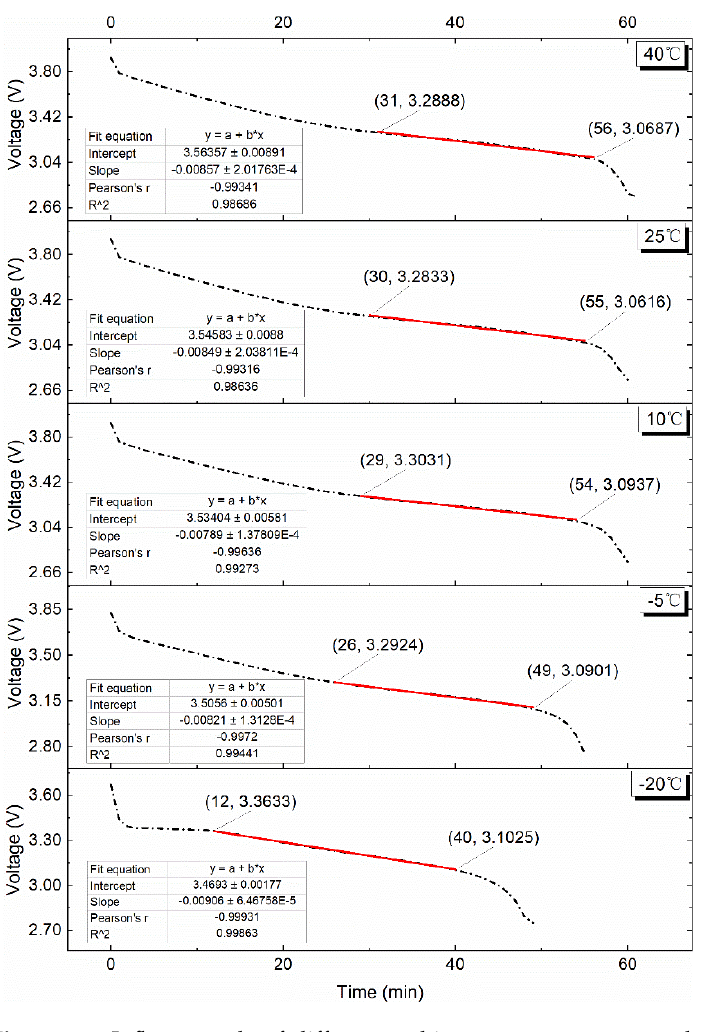
Figure 15. Influence rule of different ambient temperatures on voltage plateau period during 1C discharge.